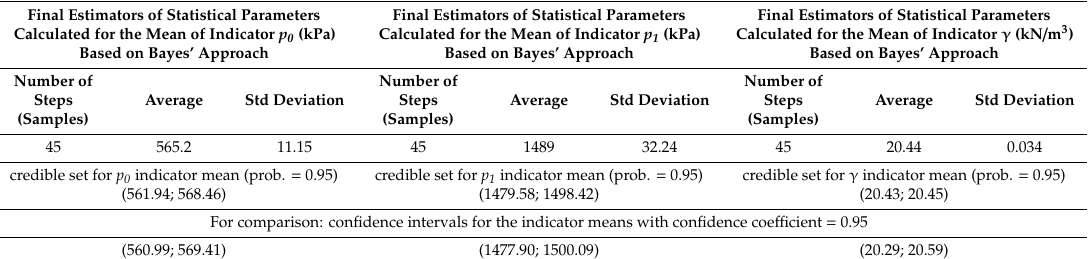
Table 5. Final results for indicators p 0 , p 1 , and γ in the clayey silt and Pliocene clay layers.